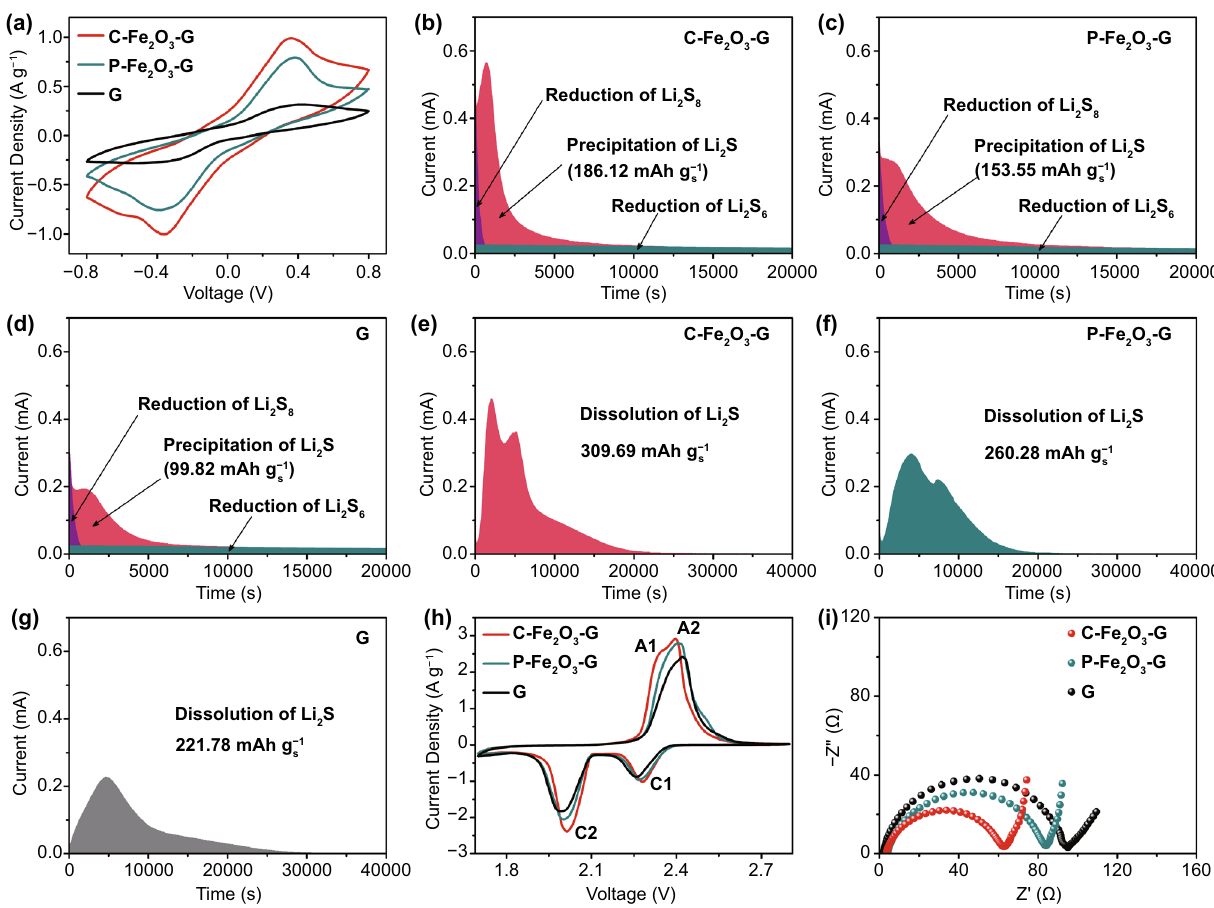
Fig. 3 a CV curves of the symmetric batteries with C-Fe 2 O 3 -G, P-Fe 2 O 3 -G and G electrodes. Potentiostatic discharge profiles of Li 2 S nucleation on b C-Fe 2 O 3 -G, c P-Fe 2 O 3 -G and d G. Potentiostatic charge profile of Li 2 S dissolution on e C-Fe 2 O 3 -G, f P-Fe 2 O 3 -G and g G. h CV curves and i corresponding Nyquist plots of asymmetrical batteries with C-Fe 2 O 3 -G, P-Fe 2 O 3 -G and